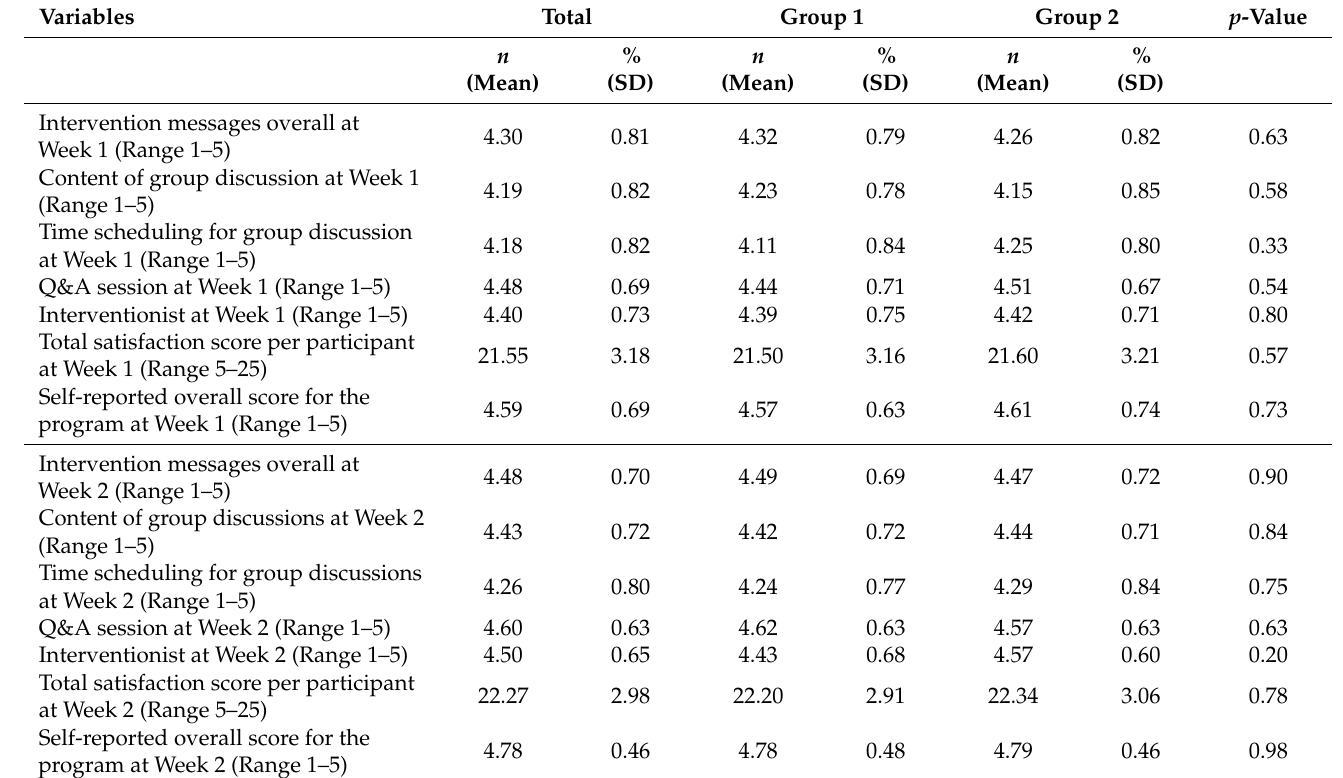
Table 3. Satisfaction scores for the